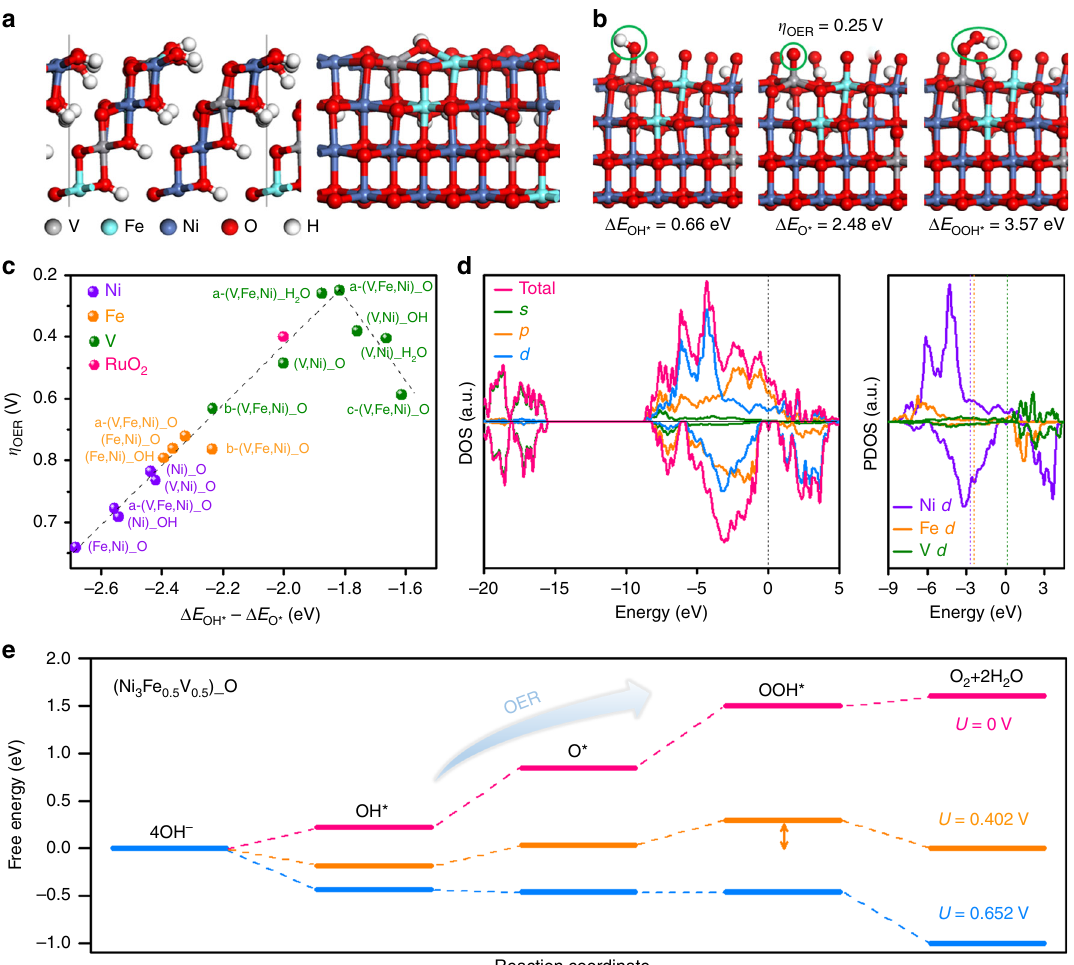
Fig. 7 DFT theoretical models. a Side views of the Fe/V co-doped Ni (oxy)hydroxide model for DFT calculations, whose (101) surface is exposed for OER catalysis. b Structures and BEs of an OH*, O*, and OOH* intermediates adsorbed on the V site of the model in a with the lowest OER overpotential of 0.25 V. The surface metal atoms are covered by O species. c Volcano plot of OER overpotential versus BE difference between OH* and O* species for various sites of Ni 3 Fe 1 − x V x (oxy)hydroxide models. For each type of reaction site, various structural models are considered, whose detailed information is given in Supplementary Fig. 28 and Supplementary Table 6. The dashed line is a guide for eyes. d Left panel: DOS of the model in a and the projected DOS on s , p , and d orbitals. Right panel: projected DOS on the 3 d orbitals of Ni, Fe, and V atoms in the model. The dashed lines represent the d -band center for each element. The Fermi level is shifted to zero. e Calculated free-energy diagram of OER on the most active site of Ni 3 Fe 0.5 V 0.5 (oxy)hydroxide in pH 14 solutions at different potentials ( T = 298 K). The two-way arrow indicates the overpotential of the rate-limiting